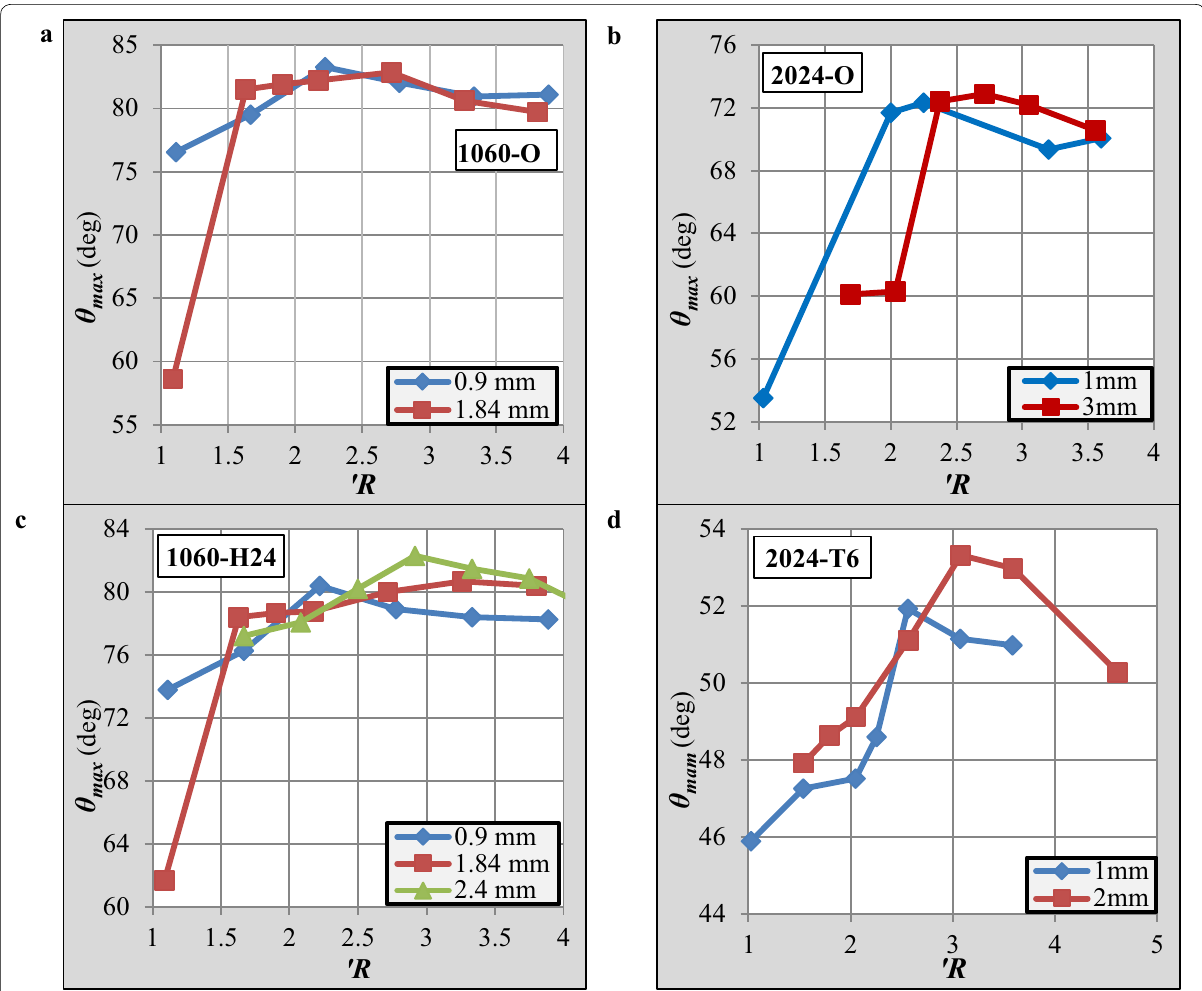
Figure 2 Formability curves of various at varying thickness: a 1060-O, b 2024-O, c 1060-H24, and d 2024-T6: avg dev in the results ranged from 0.03% to